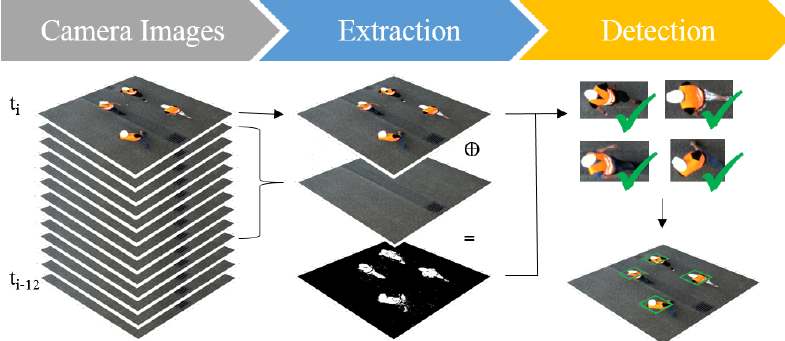
Figure 3. Concept of the classical detection approach. Each time step t corresponds to an image frame. The current frame in time step t i is subtracted from a background model which is generated from images of the previous time steps. This results in foreground blobs which represent RoIs. Image patches of the current image corresponding to these regions are fed into the classifier determining the presence of construction